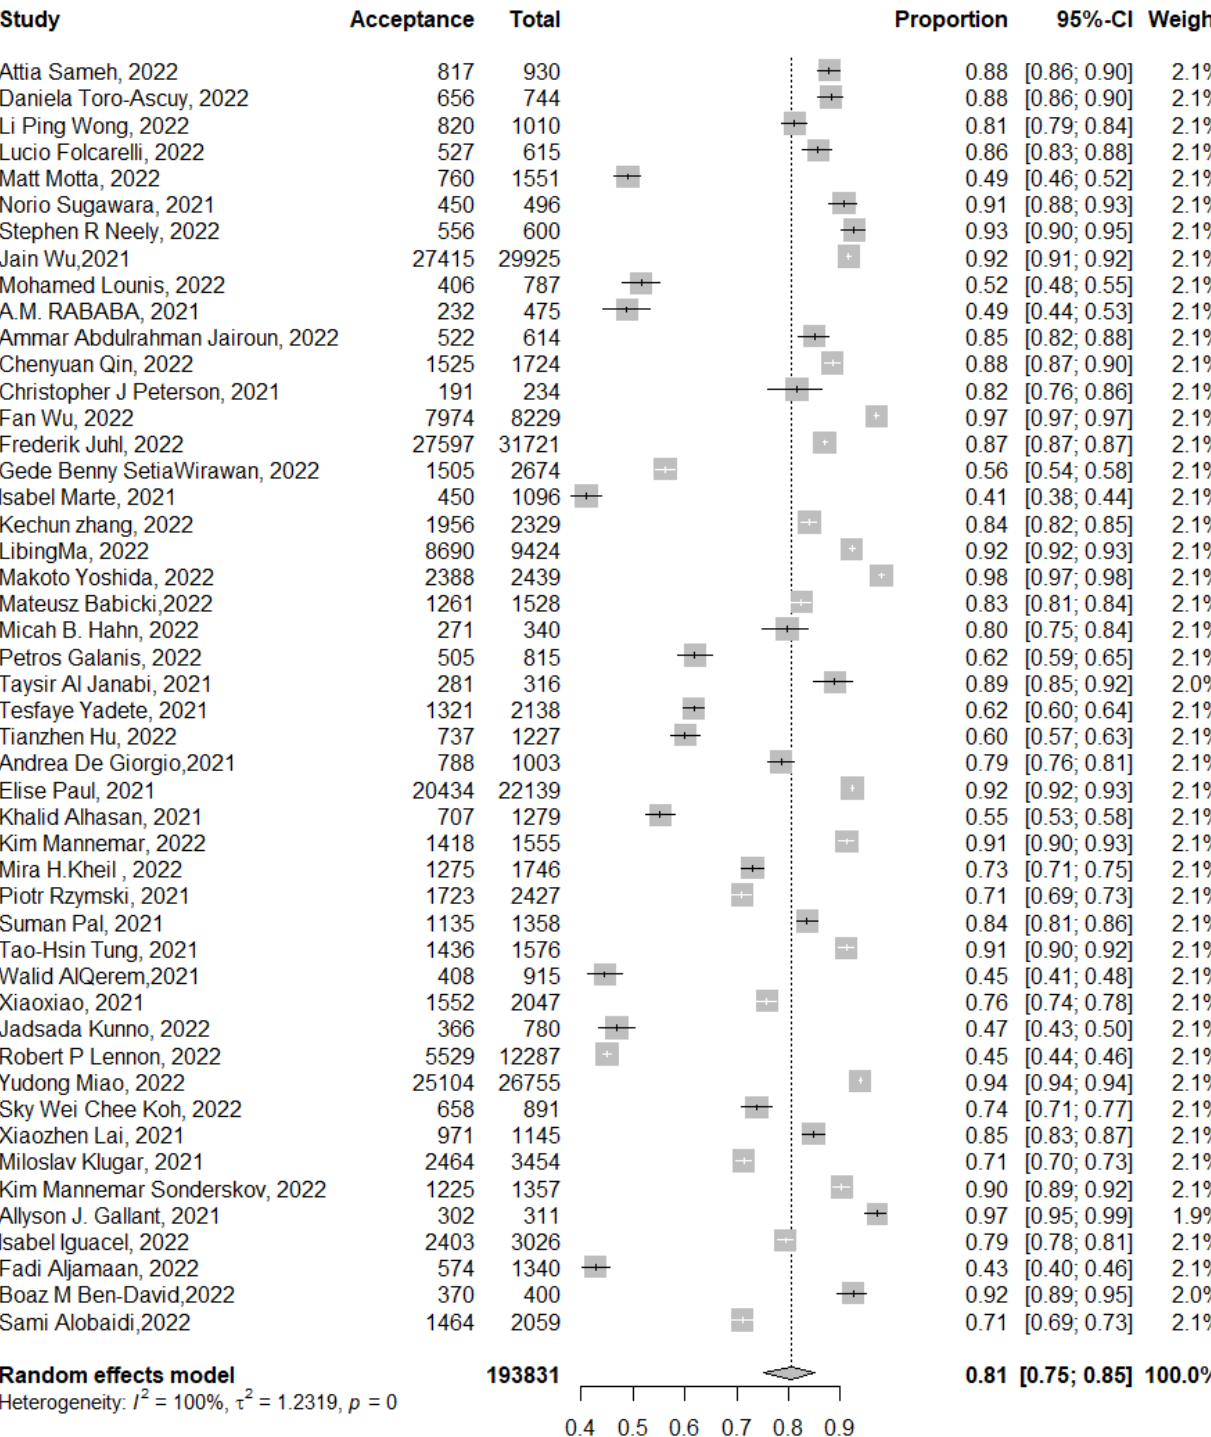
Figure 3. The pooled proportion of total COVID-19 vaccine booster dose acceptance (actual uptake and intention to take the booster dose. p = 0 denoted a p -value < 0.001.